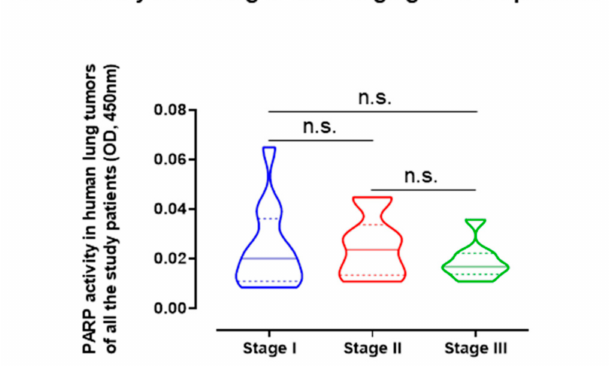
Figure 4. Violin plots with median (continuous lines) and interquartile ranges (discontinuous lines) of PARP activity levels in lung tumors according to cancer stages of all the study